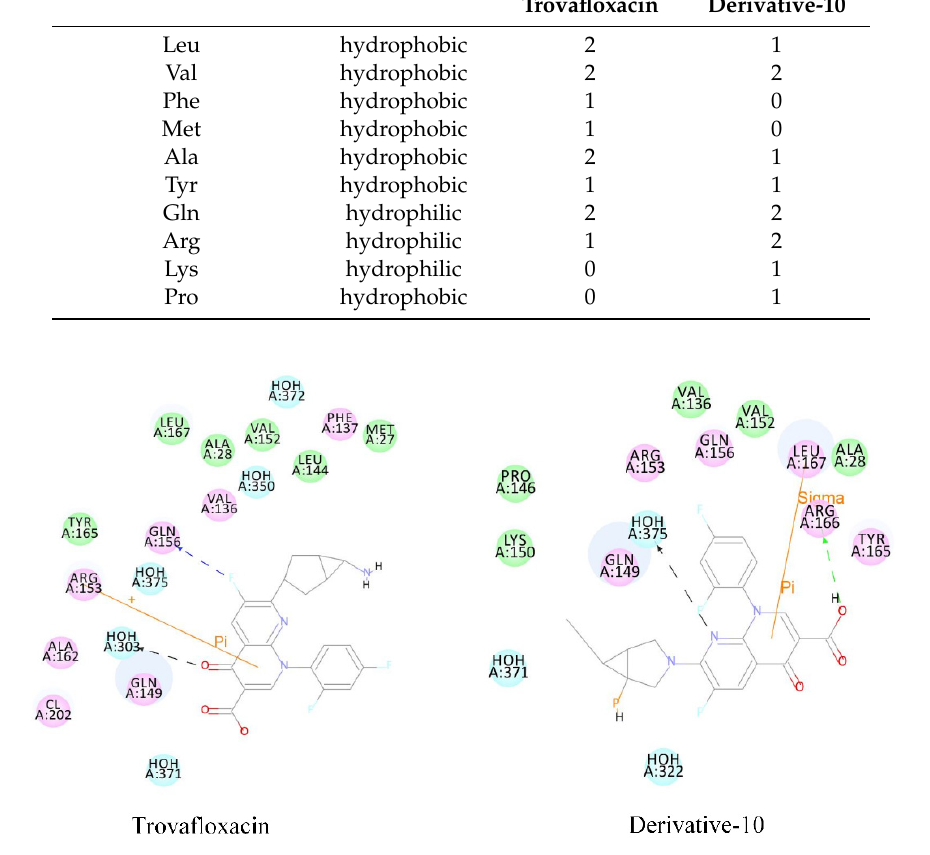
Figure 4. Molecular docking of trovafloxacin and derivative-10 with plasma protein (ID:5NU7).